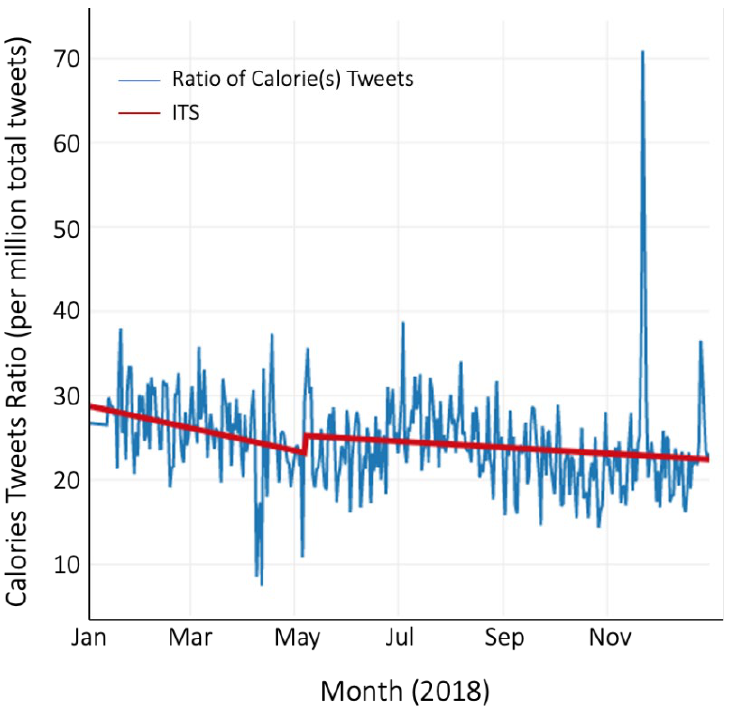
Figure 1. Interrupted Time-series of the daily ratio of calorie(s) tweets in 2018.